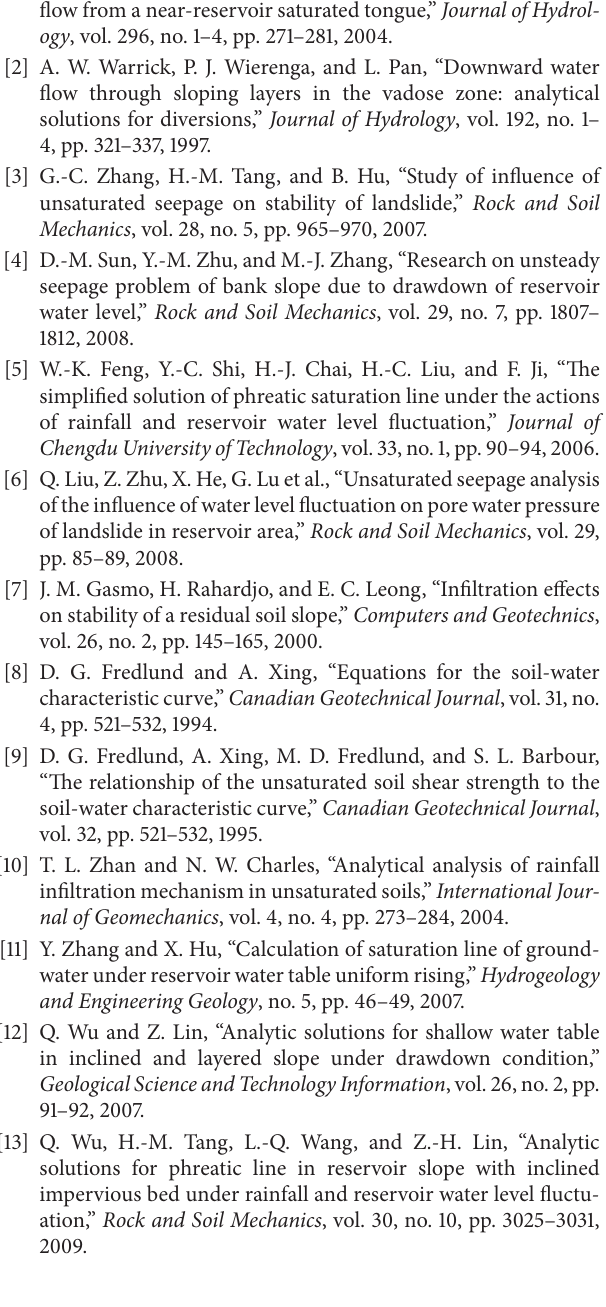
Figure 14: Comparison of calculated subgrade moisture with experimental results in Stage